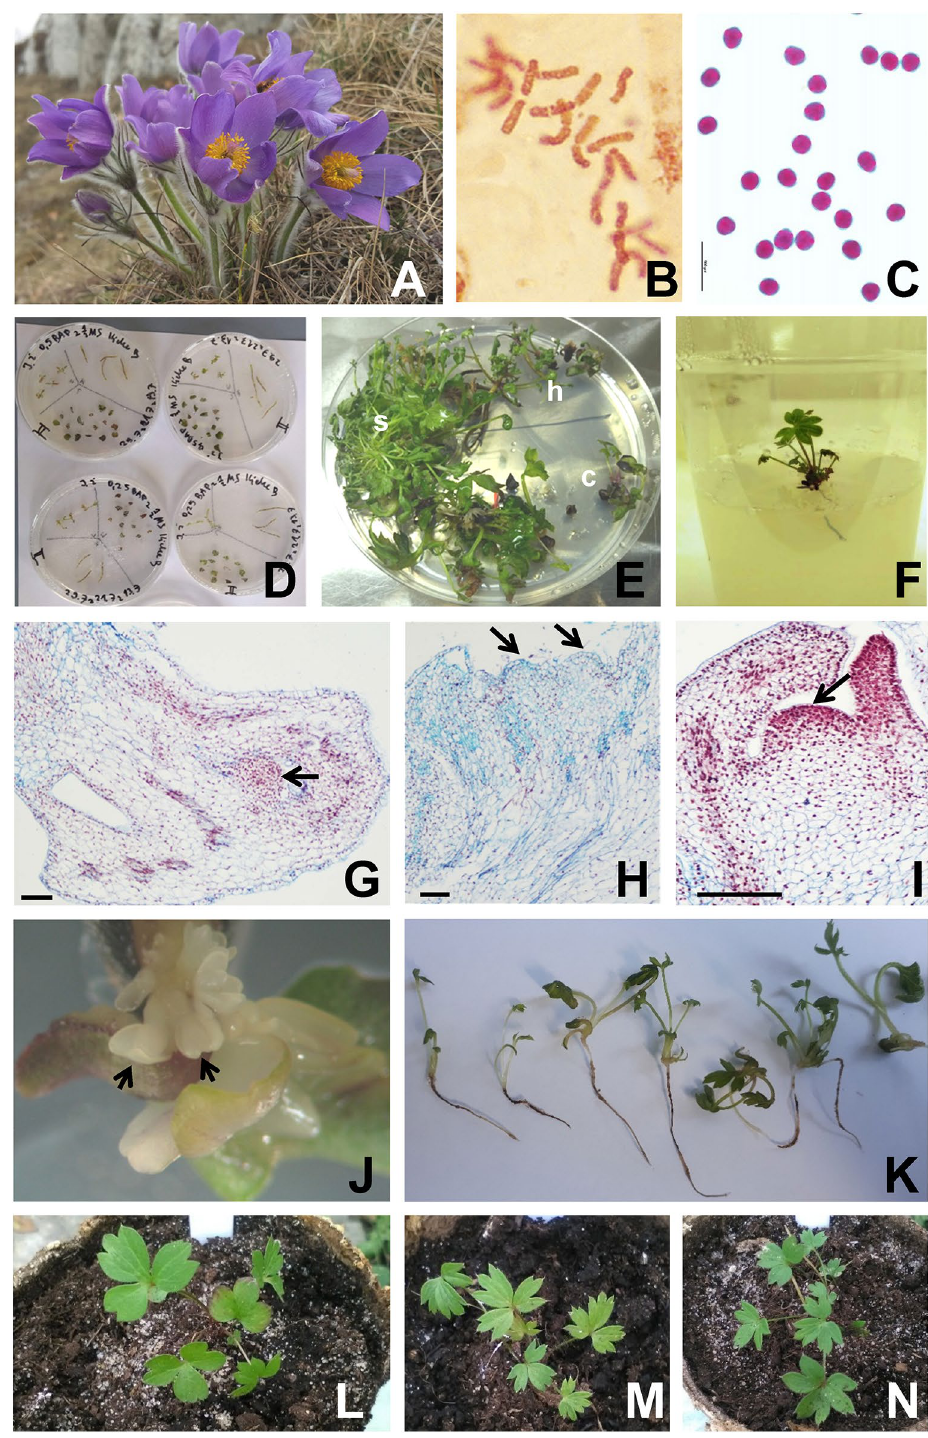
Figure 1. Pulsatilla patens micropropagation and acclimatization of regenerated plantlets. ( A ) Flowering plants in a natural stand in Łagiewniki near Busko-Zdrój, southern Poland. ( B ) Metaphase plate with 16 somatic chromosomes. ( C ) Viable (stainable) pollen grains of plants introduced to Sadowa Góra in Jaworzno. ( D ) Shoot tips, cotyledon fragments and hypocotyls with roots on induction media MS (Murashige & Skoog) + 0.25 or 0.5 mg L −1 BAP. ( E ) Organogenesis on the induction medium, varied response of explants, low of cotyledons (c), mass adventitious shoots formation on shoot tips (s) and hypocotyls (h). ( F ) Rooting on ½ MS (2% saccharose). ( G , H ) Meristematic centers (arrows) differentiated directly in the explant on induction medium. ( I ) Shoot tip (arrow), direct organogenesis. ( J ) Somatic embryos (SE) at heart stage (arrows) on explants (shoot tips) on ½ MS (2% saccharose). ( K ) Seedlings developing from SE. ( L – N ) Regenerated plantlets in ex vitro conditions in substrate, acclimatized to outdoor conditions: from somatic embryos ( L ) and from rooting adventitious shoots ( M , N ). ( G – I ) Microtome sections of explants on induction medium stained with Ehrlich’s hematoxylin and alcian blue. Bar = 100 µm ( G – I